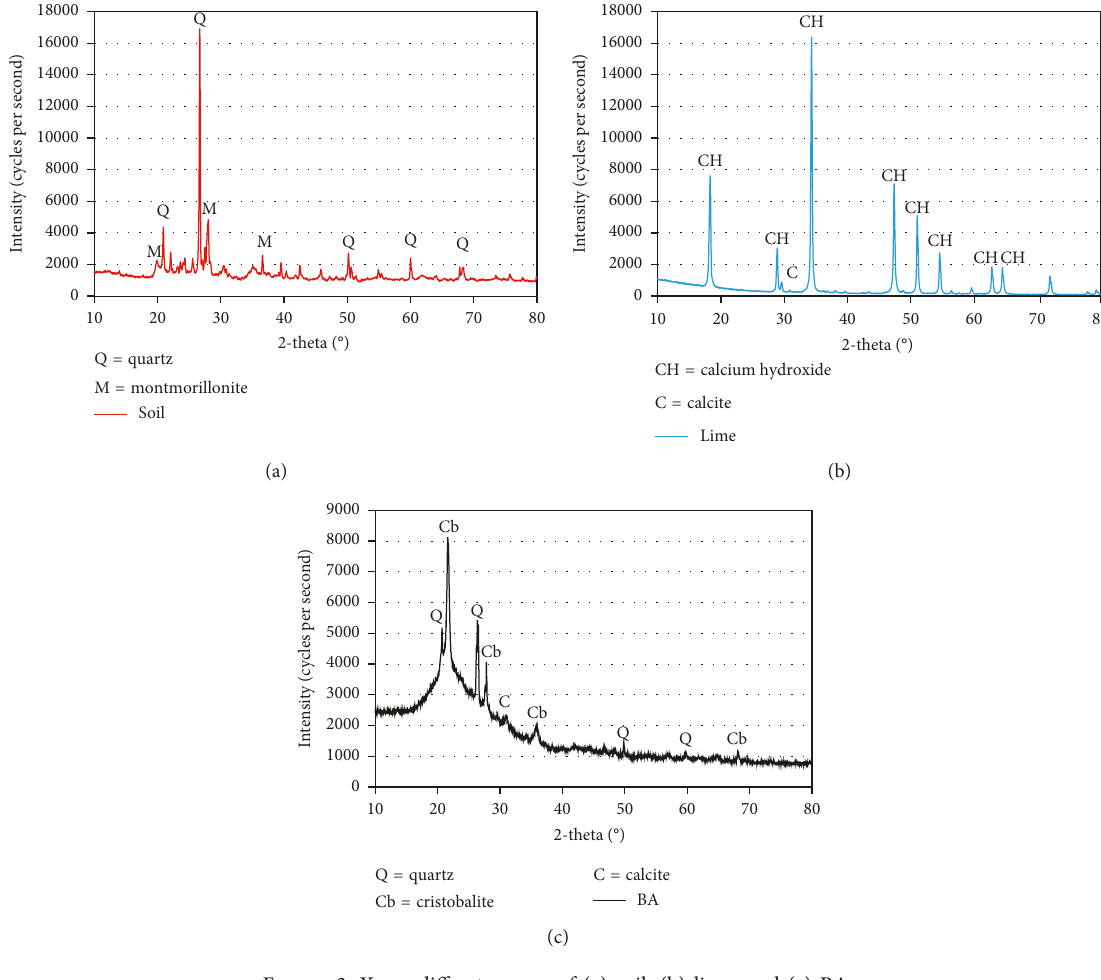
Figure 3: X-ray diffractograms of (a) soil, (b) lime, and (c)